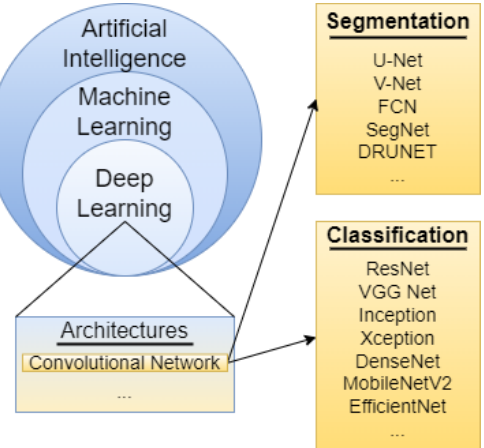
Figure 10. Common deep learning architectures explored in COVID-19